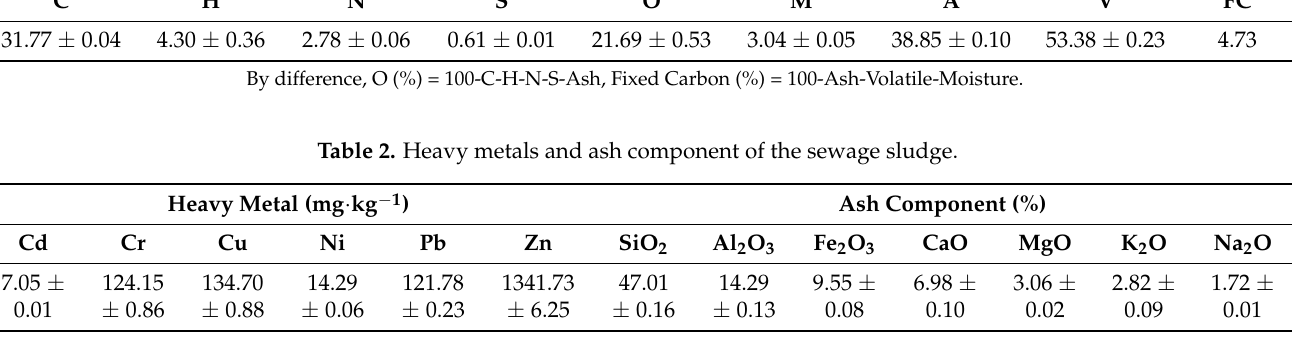
Table 1. Ultimate analysis and proximate analysis of the sewage sludge.